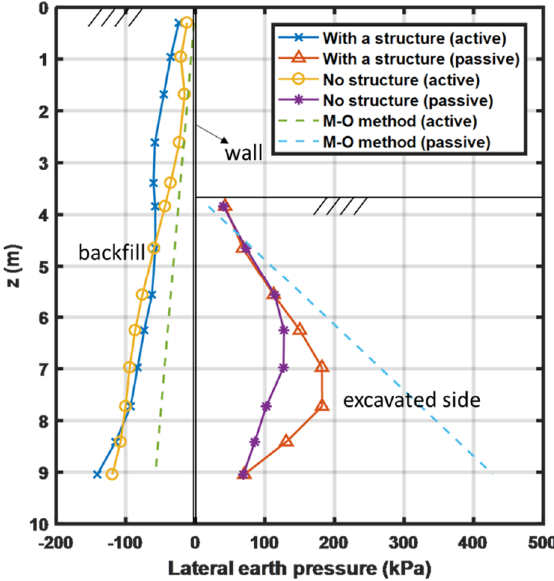
Figure 16. Distribution of maximum horizontal earth pressures acting on the retaining wall. M-O: Mononobe-Okabe.